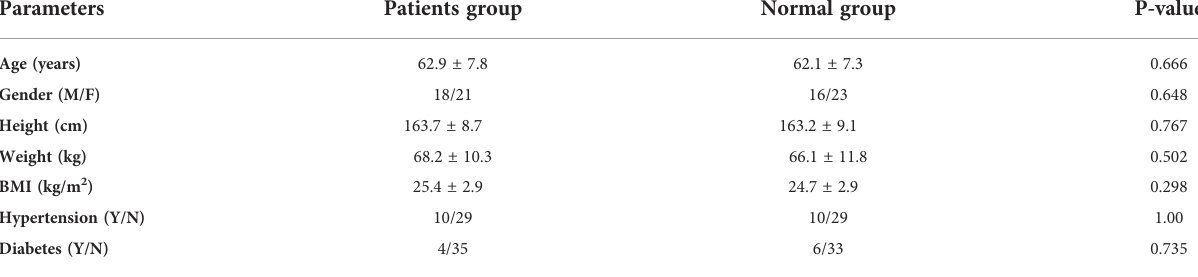
TABLE 1 The basic information of two